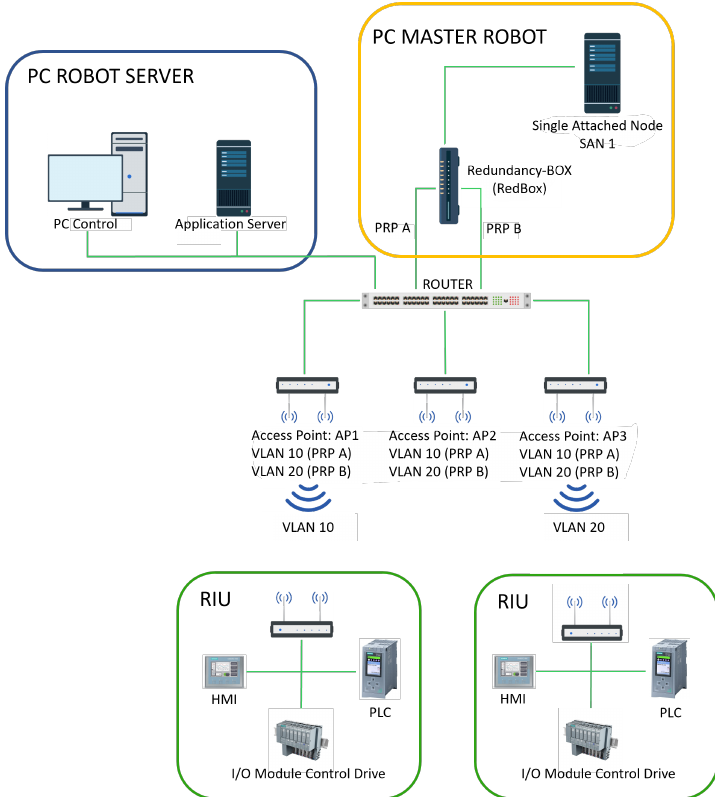
Figure 6. Schematic representation of the designed architecture of the Wi-FI network